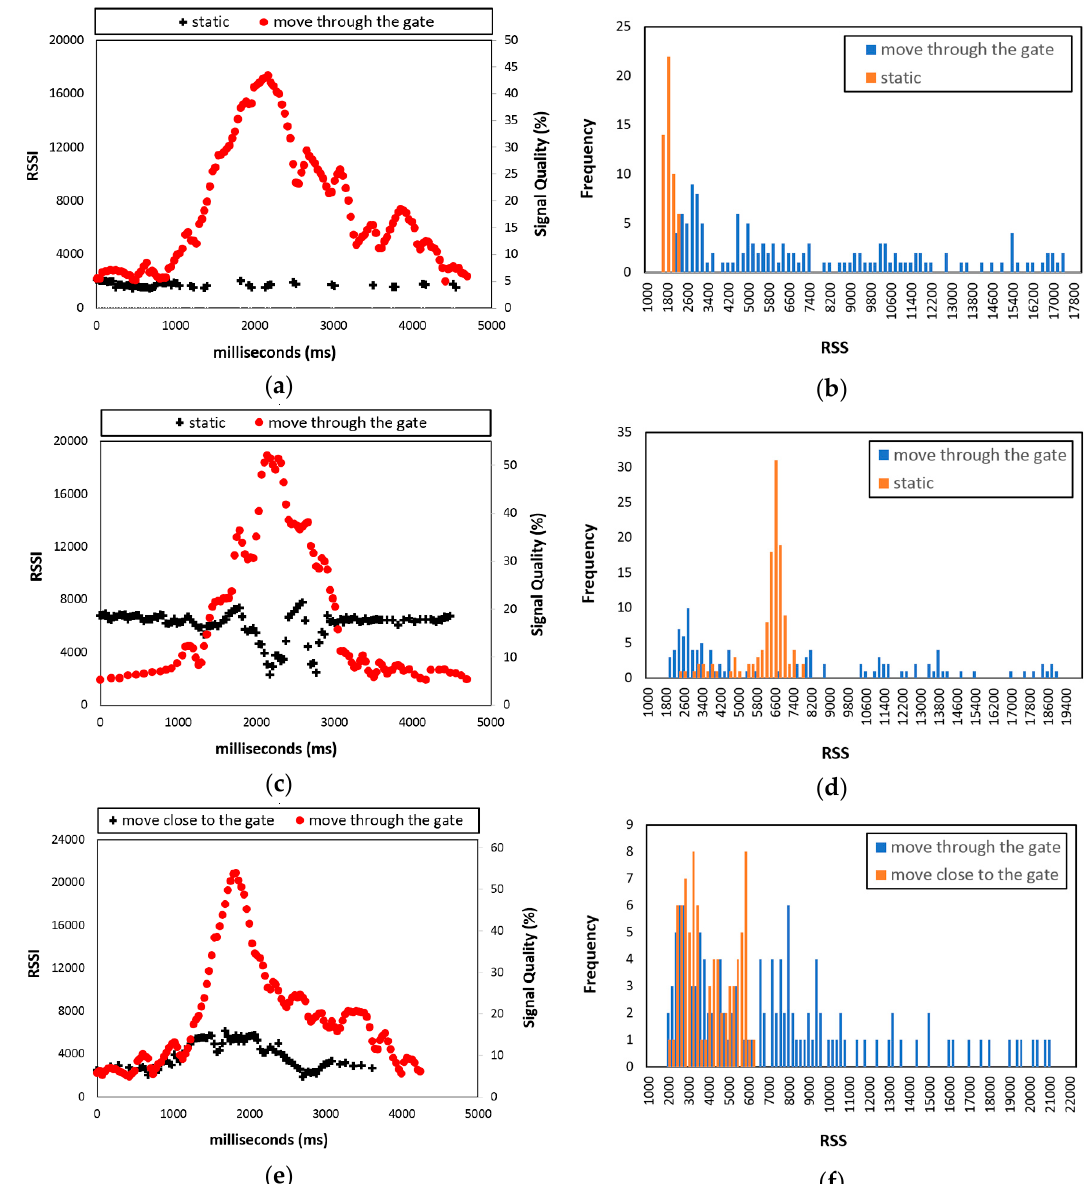
Figure 3. Typical tag RSS and corresponding histogram: ( a , b ) Relatively distant static and through the gate, ( c , d ) relatively close static and through the gate, and ( e , f ) close to the gate and through the gate. Since RSS depends on the distance between the antenna and tag, closer tags generated larger